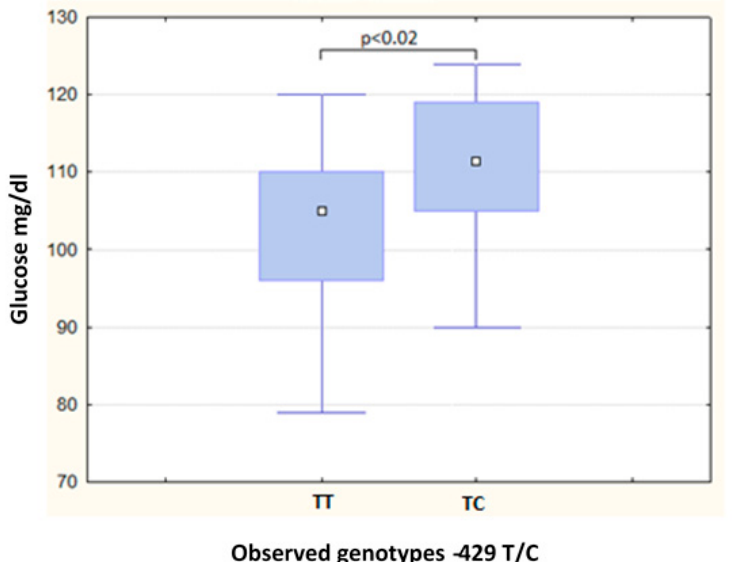
Figure 2. Differences in glucose levels among genotypes of − 429 T/C SNP in subjects with Figure 2. Di ff erences in glucose levels among genotypes of − 429 T/C SNP in subjects with metabolic Serum levels of sRAGE were similar between non-MS and MS groups. Likewise, no di ff erences were observed when comparing sRAGE levels by genotypes between non-MS and MS groups for either of the two polymorphisms (Tables 3 and 4).